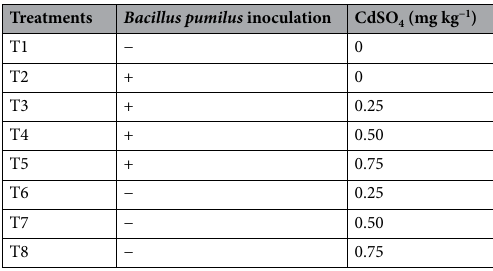
Table 1. Preparation of treatment